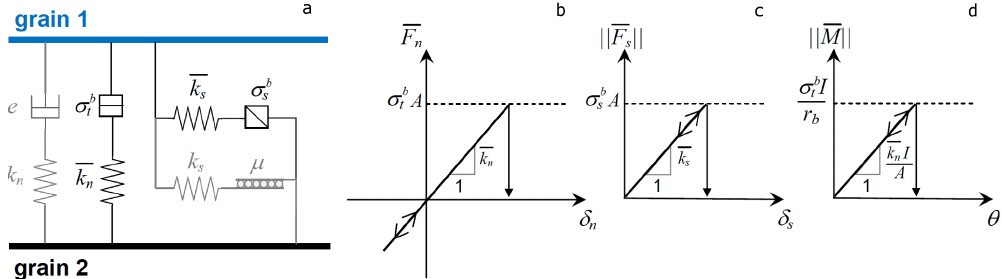
Figure 5. (a) Schematic representation of the parallel bond contact model which is used. The bonded part is represented in black while the unbonded part is represented in grey. (b) Bond normal force F n as a function of normal interpenetration δ n between two grains. (c) Bond shear force || F s || as a function of tangential interpenetration δ s between two grains. (d) Bond bending moment || M || as a function of bending rotation θ between two grains.